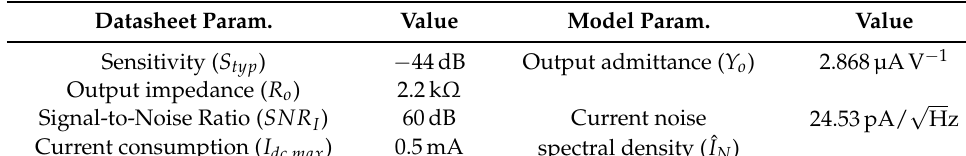
Table 1. Model parameters for CMA-4544PF-W electret condenser microphone. Datasheet Param.